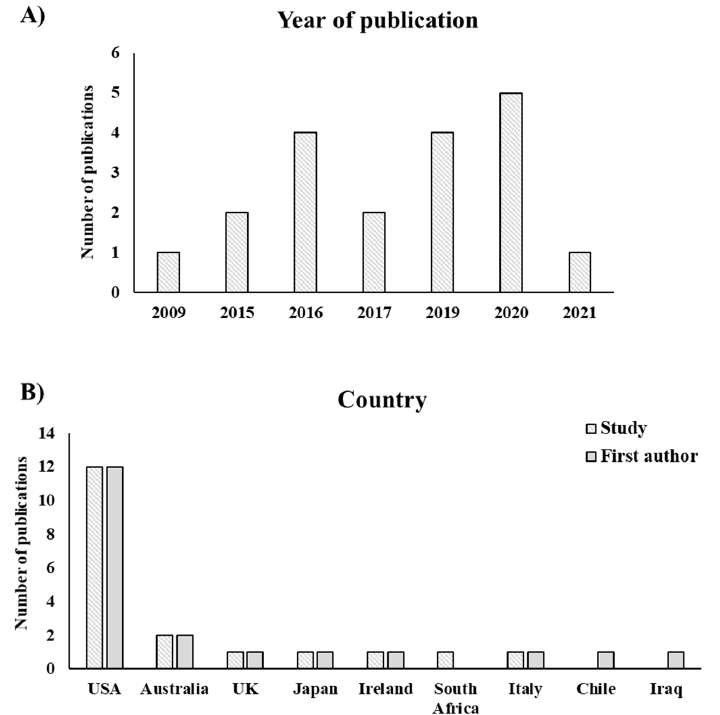
Figure 1. ( A ) Number of publications by year of publication; ( B ) country of the study and country of